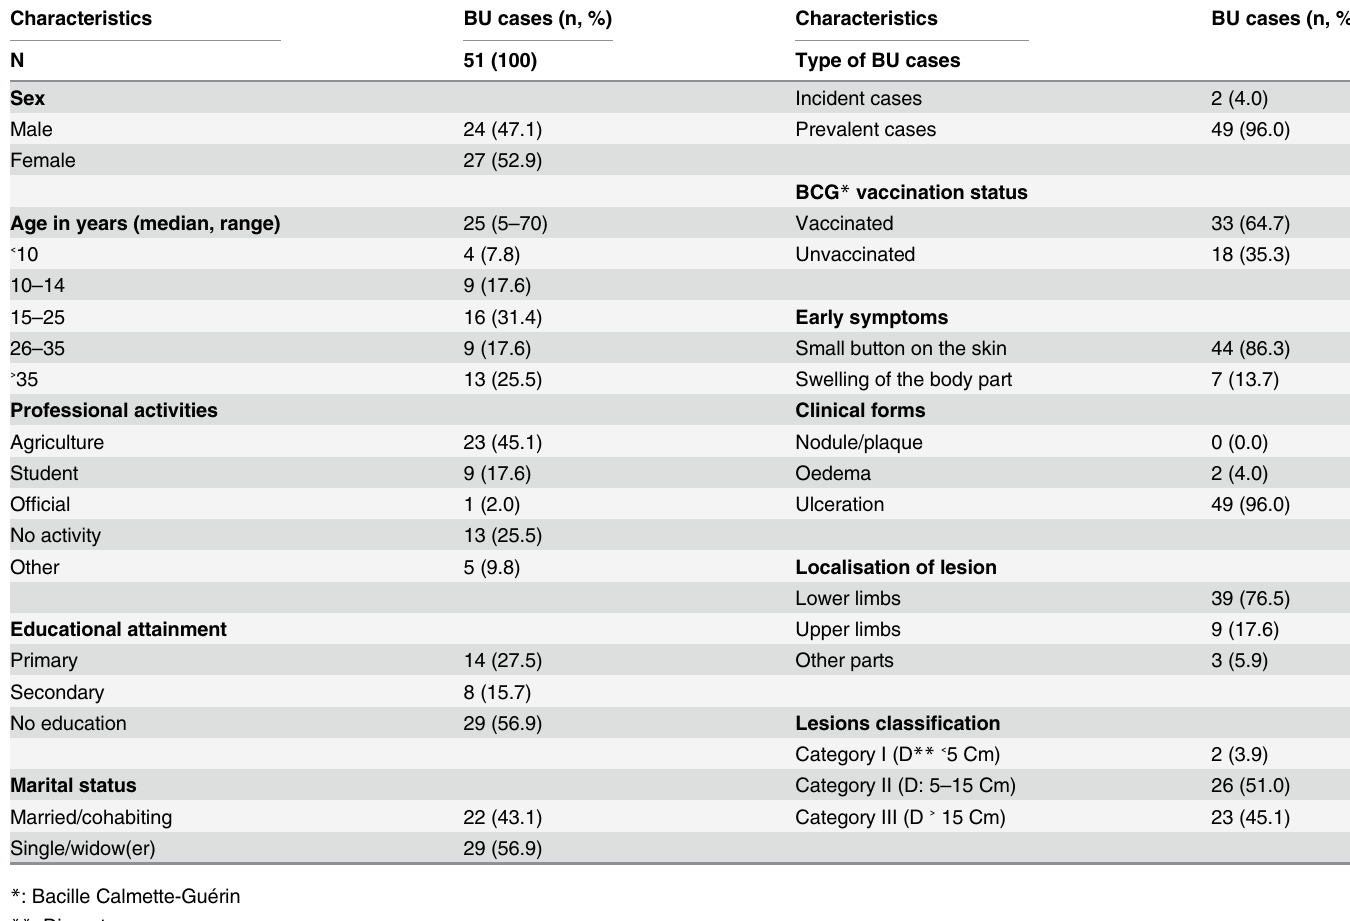
Table 1. Socio-demographic and clinical characteristics of BU cases in the district of Tiassalé, south Côte d'Ivoire (community-matched case con- trol study, August-September 2012). Characteristics BU cases (n,